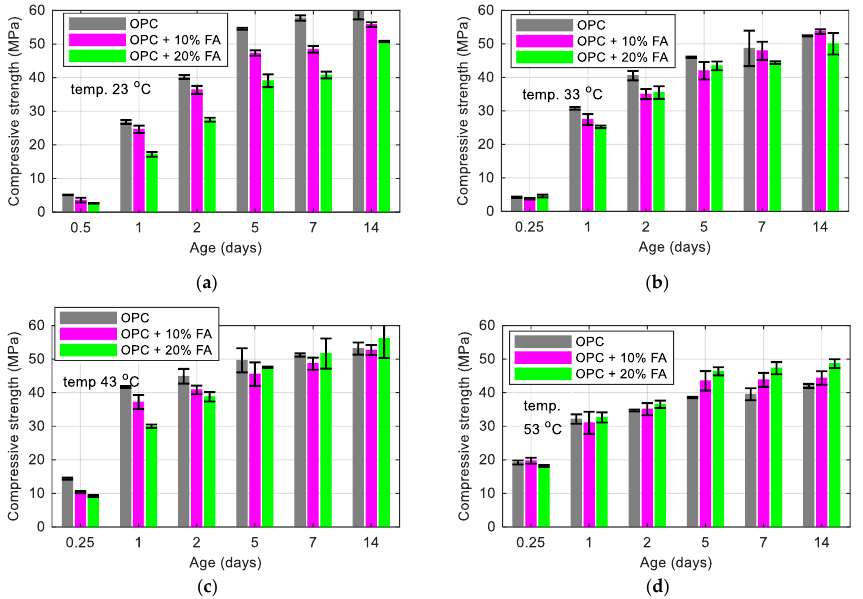
Figure 4. Average compressive strength of mortar specimens cured at different temperatures: ( a ) 23 °C; ( b ) 33 °C; ( c ) 43 °C; ( d ) 53 °C.